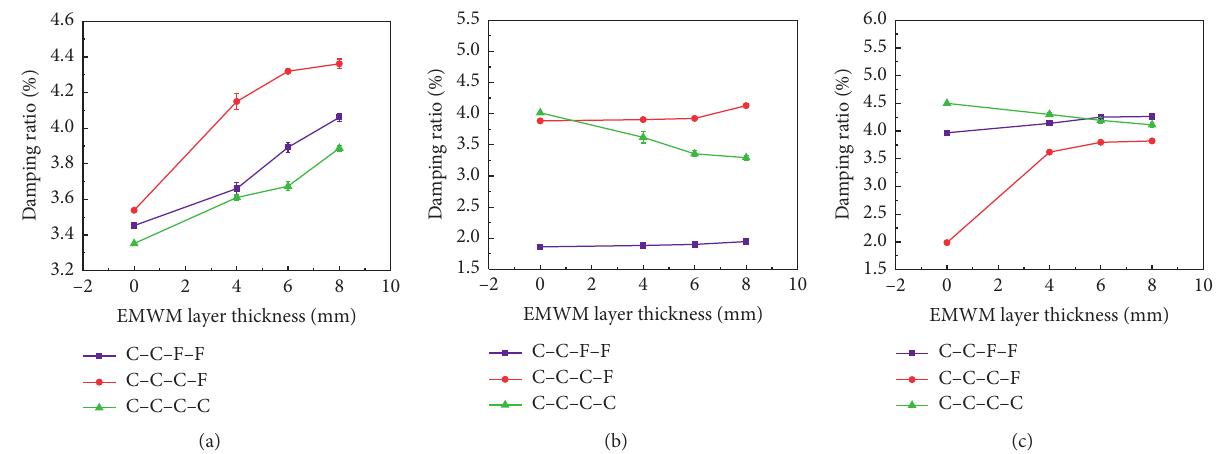
Figure 12: The damping ratios of the steel plate (baseplate) and composite structures with different core thicknesses under different boundary conditions. (a) First order, (b) second order, and (c) third order. Table 5: First three-order modal shapes of the baseplate and composite structures under different boundary conditions.